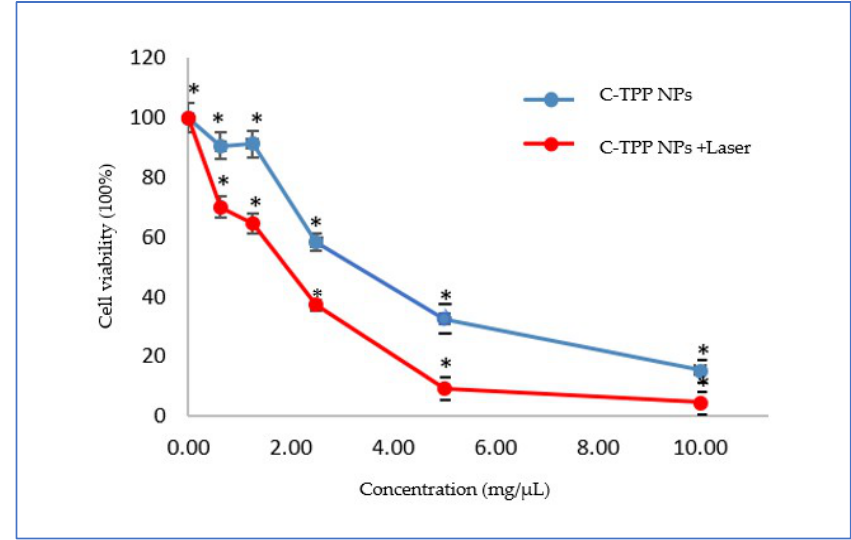
Figure 3. Cell viability assay on Caco2 cells versus the concentrations of C-TPP NPs, in the absence and in the presence of laser irradiation Data presented as mean ± SD. *P < 0.05 compared between the two groups.